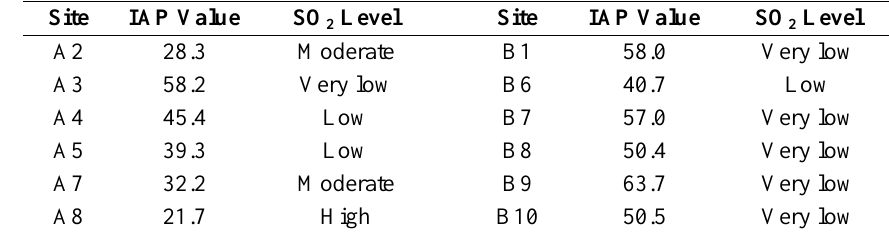
Table 5: IAP values for each site in